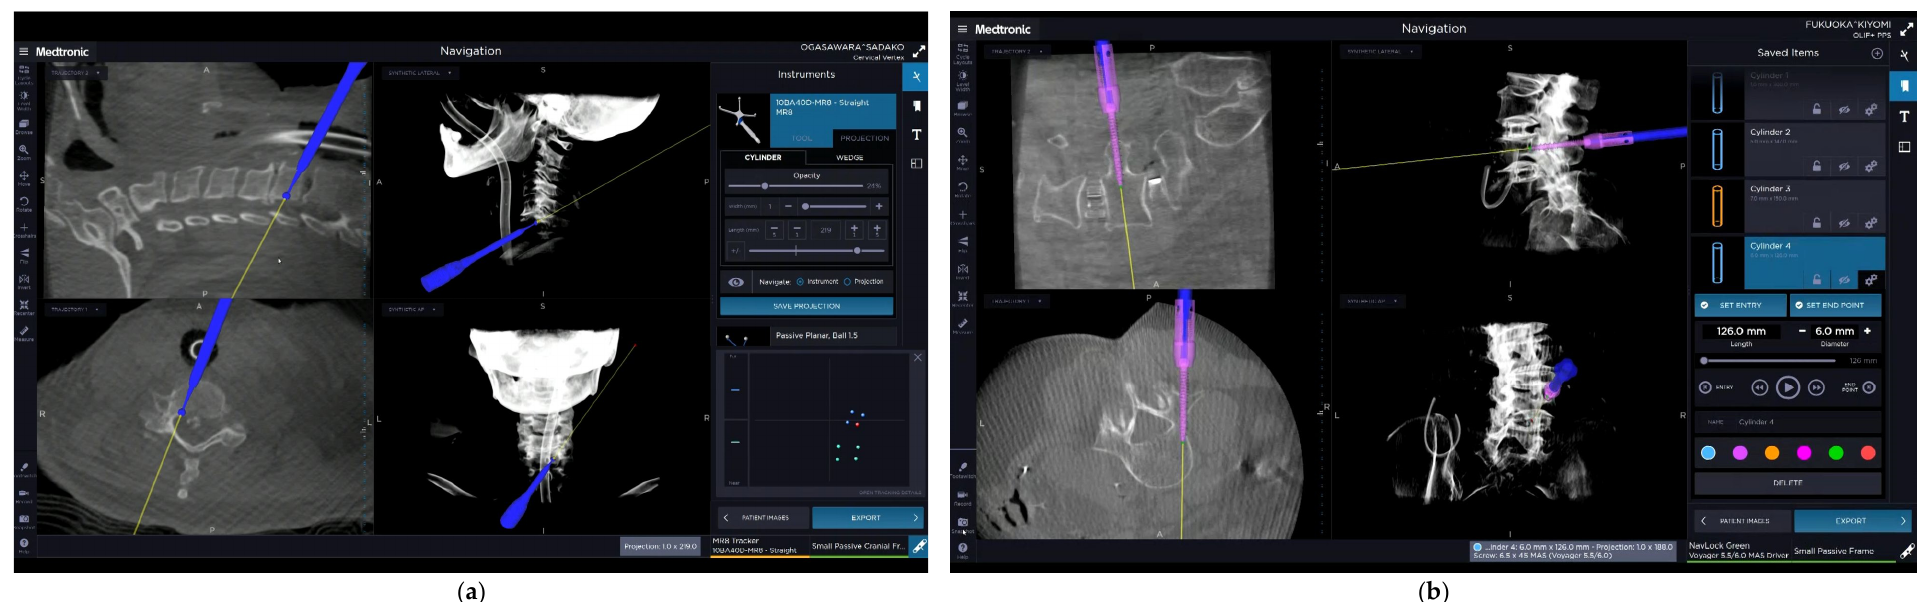
Figure 5. O-arm ® navigation monitor images. ( a ) Anterior floating surgery in cervical ossification posterior longitudinal ligament (OPLL); ( b ) percutaneous pedicle screw (PPS) insertion.